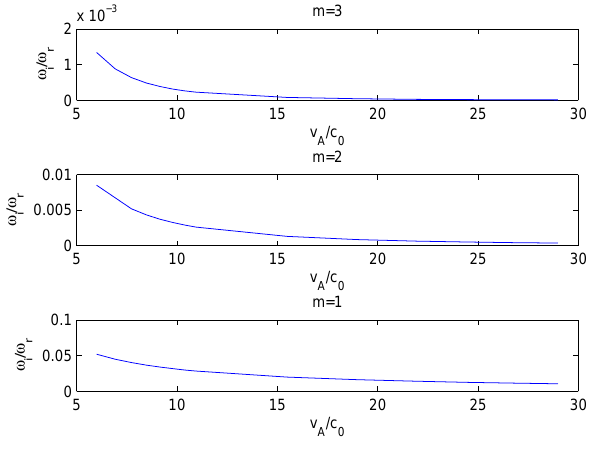
Fig. 3. The ratio of imaginary ω i and real ω r parts of wave fre- quency vs the ratio of Alfv ´ en and sound speeds for m = 1 , 2 , 3 har- monics.